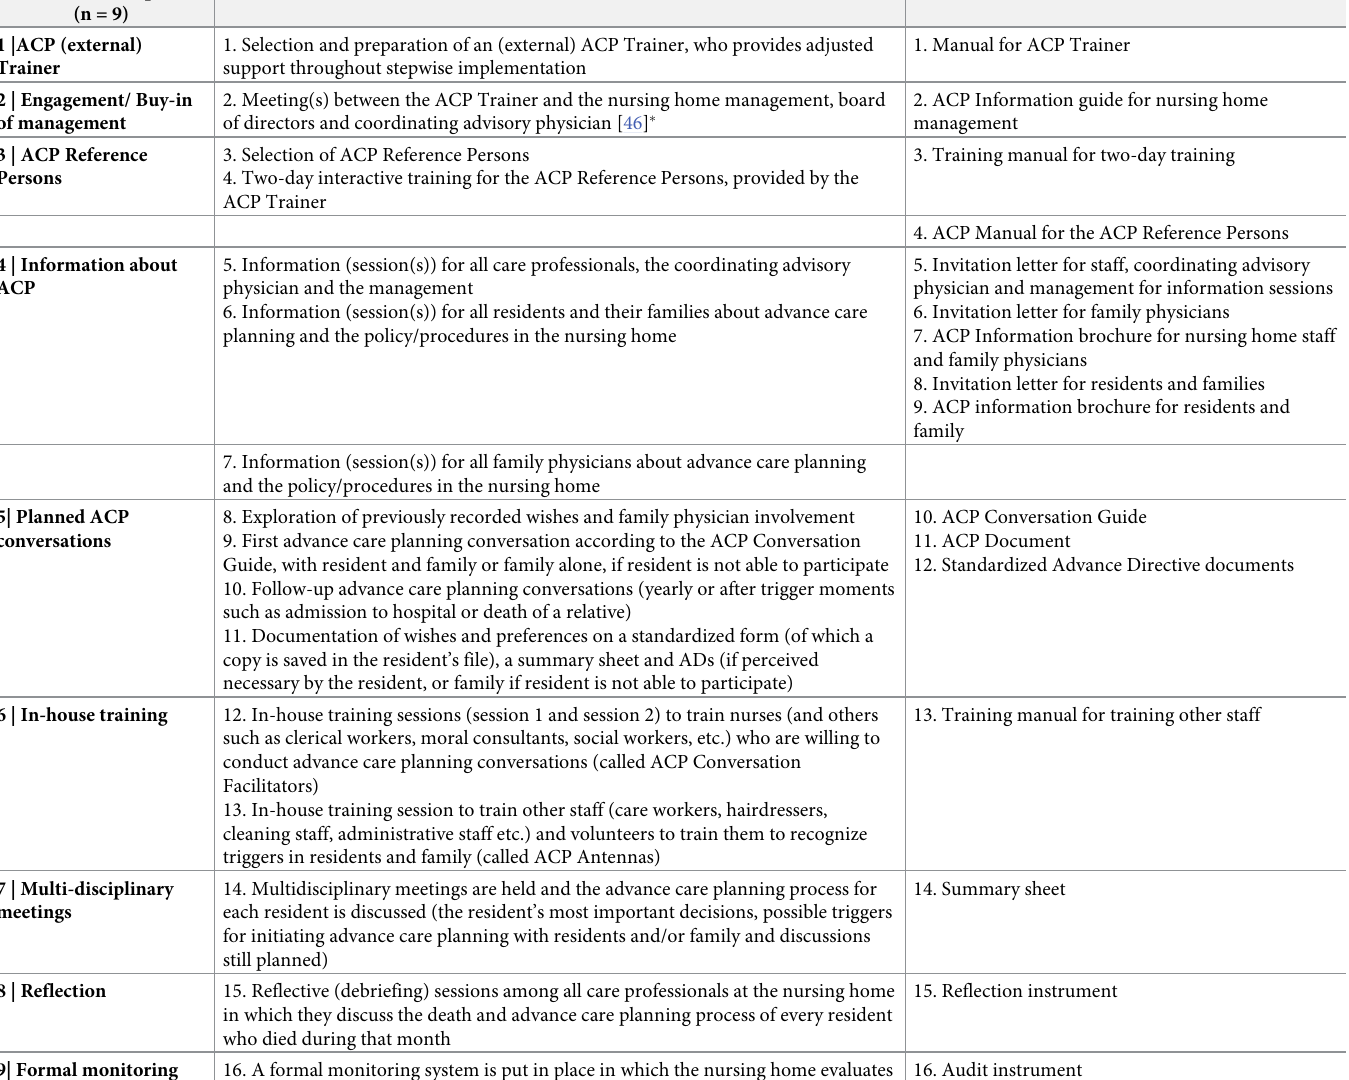
Table 1. ACP+ intervention components, intervention activities and materials (results of step 1, prior to evaluation of feasibility and acceptability). Intervention component (n =